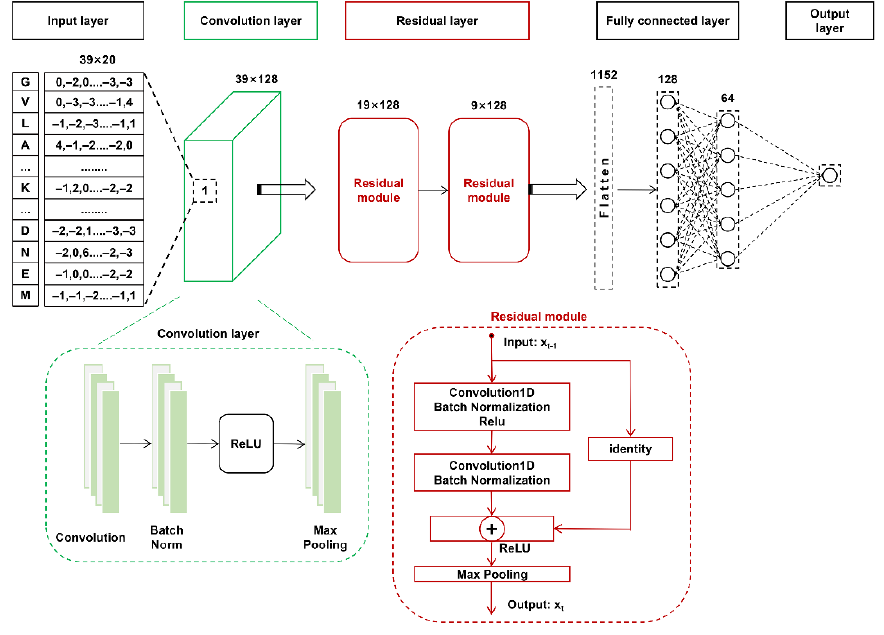
Figure 2. The architecture of the RSCNN model. The BLOSUM62 feature was used as the character- istic matrix of the input layer.